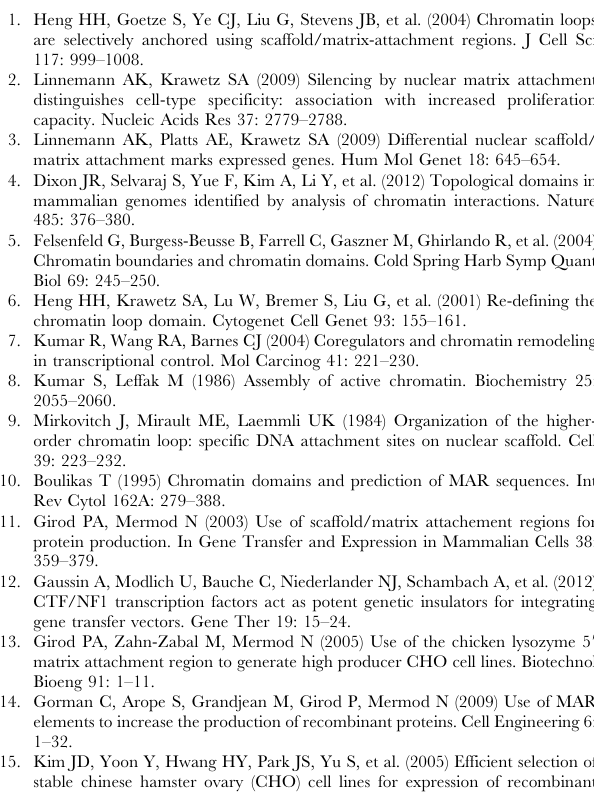
Figure S6 1683 predicted human MAR genomic loca- tions were aligned using the central positions of their AT rich cores. ChiP-Seq profiles were calculated over the MAR collection for association with the CTCF transcription factor, for DNAse hypersensitive sites and for the H2AZ histone variant. Tag counts were normalized globally and they are expressed as a fold change over the non-precipitated input DNA profile. (PDF) Table S1 Primer sets used to amplify portions of MAR 1–68 and MAR X-29. (PDF) Table S2 Primers sets used to amplify control cDNA sequences. (PDF) Table S3 Oligonucleotides containing transcription fac- tor binding motifs. (PDF) Table S4 Quantitative PCR primer sets for GFP, GAPDH and eEFIA.